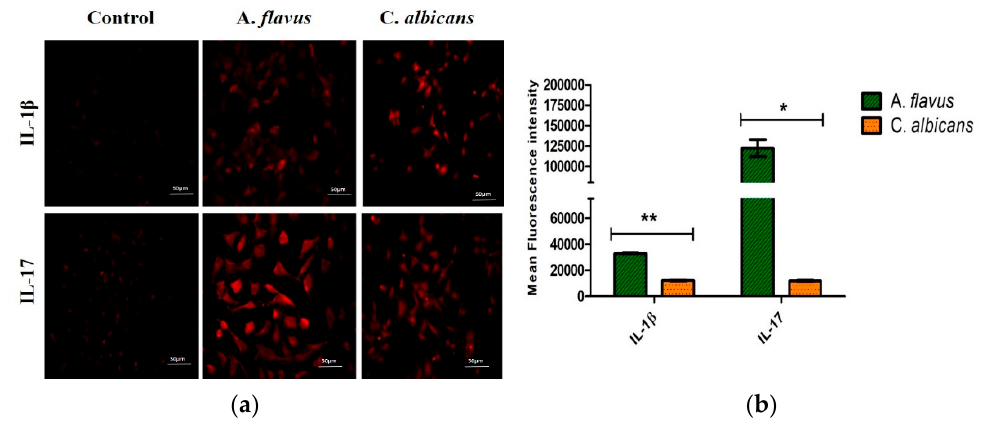
Figure 5. ( a ) Representative images of microglial cells infected with A. flavus and C. albicans were stained with anti-IL-17 and anti-IL-1 β , labeled with Alexa 594 (red) after 12 h p.i. and uninfected CHME-3 cells were taken as control. Magnification 20 × . ( b ) The bar graph depicting cell fluorescence intensity (normalized to background) in microglial cells challenged with A. flavus and C. albicans measured using NIH Image J software. Relative immunofluorescence staining was quantified from randomly selected fields. Values represent the mean fluorescence intensity ± SE (gray-value of 16-bit images). * p < 0.05, ** p < 0.005.